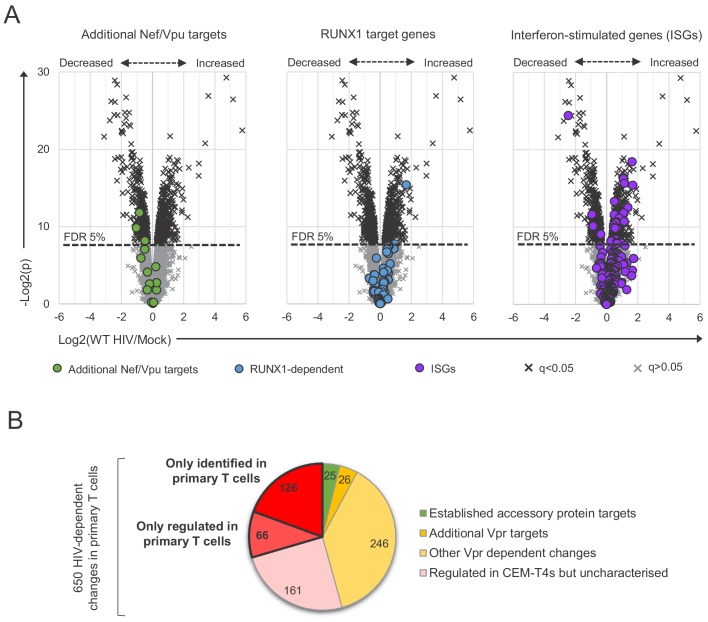
Comparison with HIV-dependent changes in other datasets.(A) Protein abundances in WT HIV-infected vs mock-infected cells from single time point proteomic experiment (Figure 3A), with details for volcano plots as in Figure 3C. Proteins highlighted in each plot are summarised in the key. Additional Nef/Vpu targets (green circles) comprise (alphabetical order, grouped by study): CCR7 (Ramirez et al., 2014), CD37/CD53/CD63/CD81/CD82 (Haller et al., 2014; Lambelé et al., 2015), CD99 (two quantitated gene products, H7C2F2 and P14209)/PLP2/UBE2L6 (Jain et al., 2018), ICAM1/3 (Sugden et al., 2017), NTB-A (Shah et al., 2010), PVR (Bolduan et al., 2014; Matusali et al., 2012), SELL (Vassena et al., 2013). RUNX1 target genes (blue circles) were previously reported to be regulated by Vif at a transcriptional level because of competition for CBFβ binding (Kim et al., 2013). ISGs (purple circles) were previously curated from published microarray data sets from IFN-treated cells (Schoggins et al., 2014; Schoggins et al., 2011). (B) Mechanisms underlying significant HIV-dependent proteins changes (q < 0.05) in single time point proteomic experiment (Figure 3A). Established accessory protein targets from Figure 3C (left panel, 22 proteins) and (A) (left panel, three proteins) and additional Vpr substrates and Vpr-dependent changes from Figure 3C (middle panel) are shown. Amongst the 32 additional Vpr substrates depleted in primary T cells, 26 had q < 0.05. Remaining proteins are categorised based on the identification plus/minus HIV-dependent regulation in a previous, similar experiment using CEM-T4s (Greenwood et al., 2019). Of 131 proteins not identified in the comparator CEM-T4 dataset, one is known Vpr target SMUG1 (Schröfelbauer et al., 2005) and four other proteins were found to be regulated by Vpr in other experiments using CEM-T4s (ZNF512B, ATXN7, CLUH and SLC39A3) (Greenwood et al., 2019). Further details on comparator datasets used in this figure are provided in the Materials and methods.